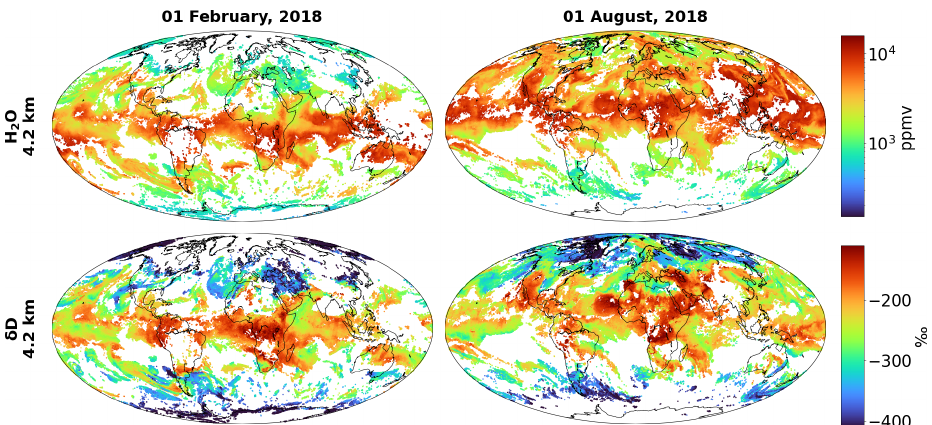
Figure 10. Horizontal distributions of H 2 O and δ D from the optimal estimation pair product, after filtering according to Table 1. Data are shown for 4.2kma . s . l . and for 1 February and 1 August 2018 (including both morning and evening observations). The range of the colour bars is adjusted to Fig. 15 of Schneider et al.